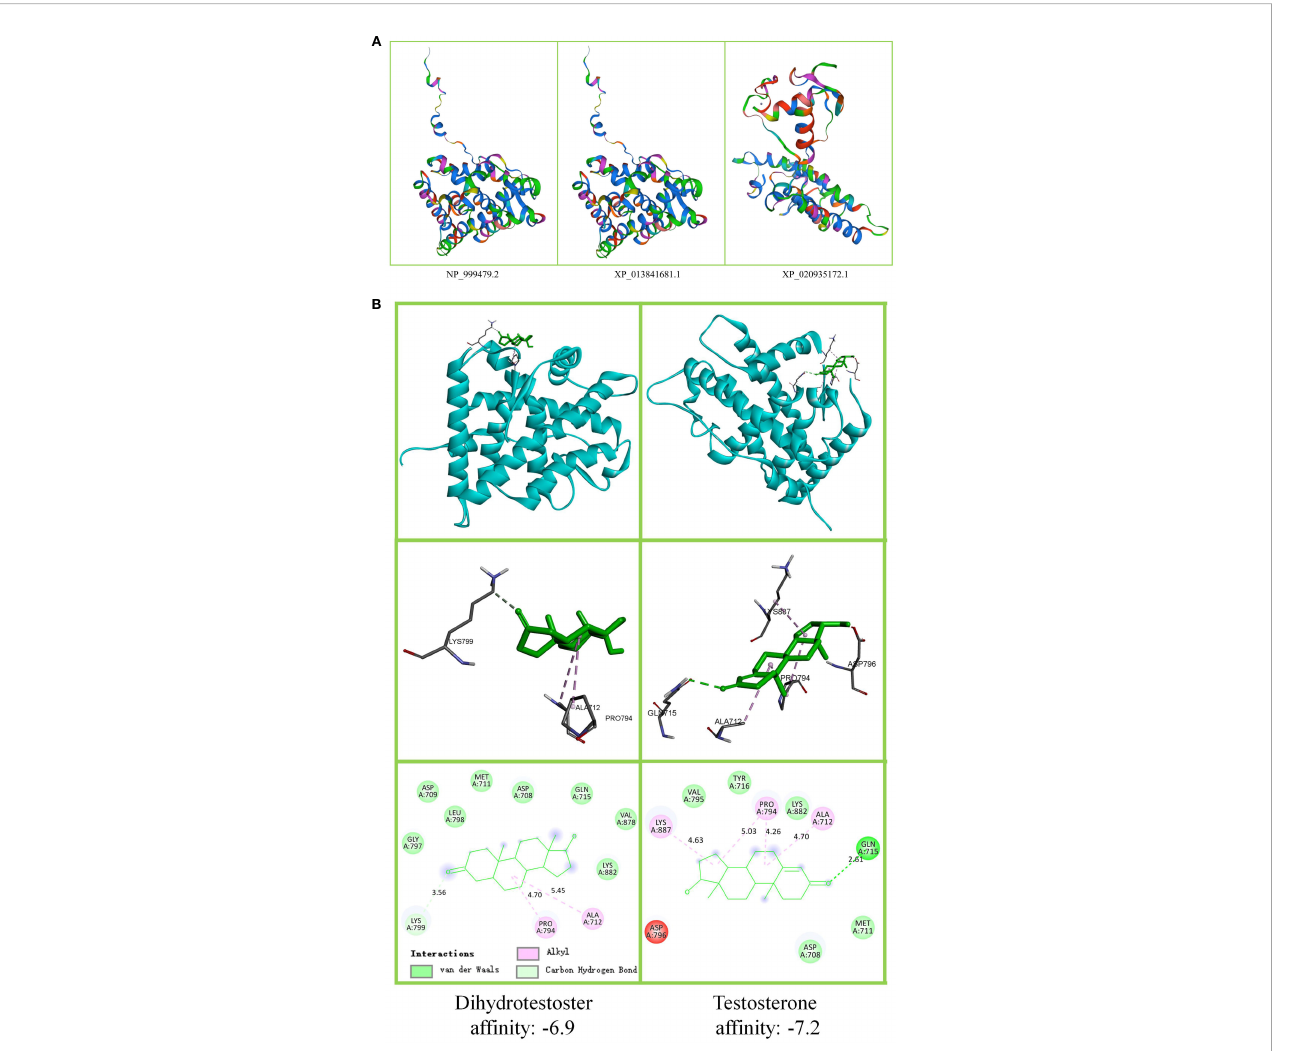
FIGURE 4 Androgen receptor protein tertiary structure and ligand docking. (A) Swine androgen receptor protein tertiary structure. The fi gure shows that 352 N > H, 410 P > S has no effect on NP_999479.2 (896aa) and XP_013841681.1 (896aa) tertiary structure. XP_020935172.1 (800aa) lost 96 amino acids, and the tertiary structure was altered. (B) T/DHT docking to the androgen receptor protein. The upper part shows that T and DHT docking to swine androgen receptor ligand-binding domain (sARLBD) is the same. To show the connecting bridges, the observation direction has been adjusted. The middle part is the local ampli fi cation of the ligand-binding pocket (LBP). The lower part shows the binding af fi